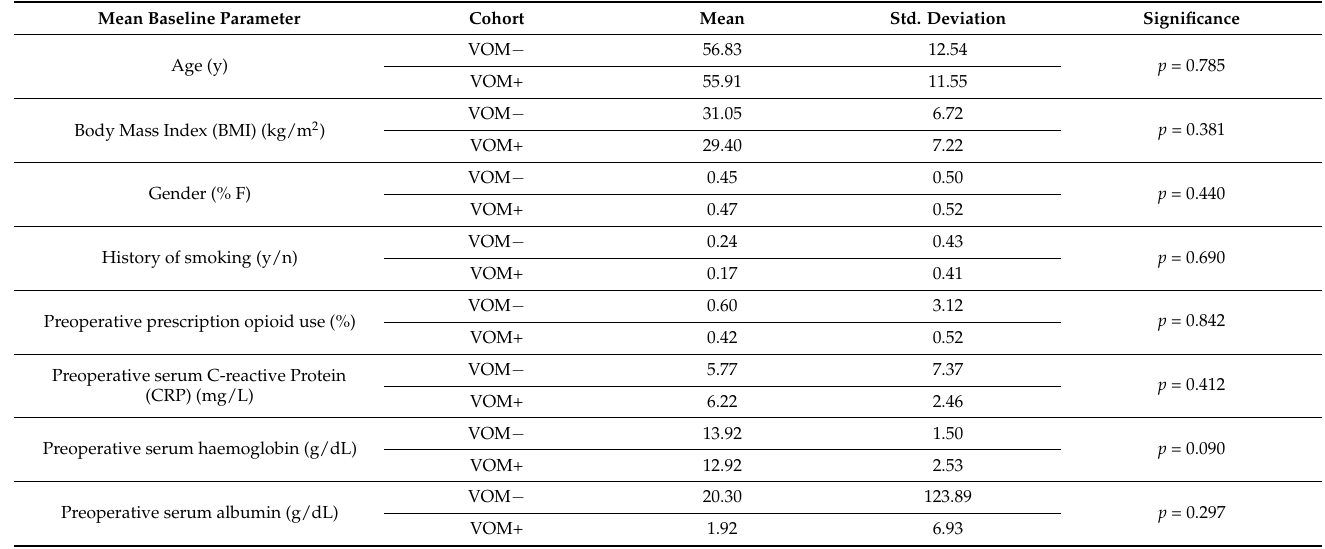
Table 1. Baseline demographic comparisons of VOM+ and VOM − patients.